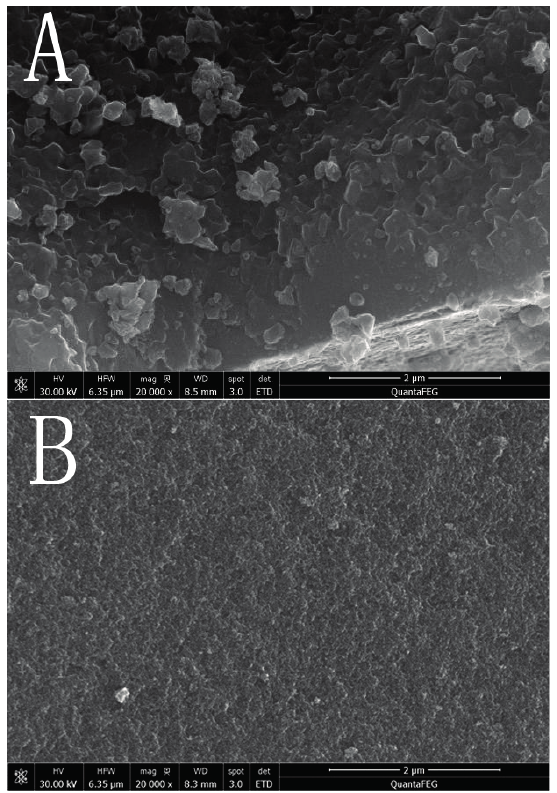
Figure 3. SEM images of TiO 2 ( A ) and La/Fe/TiO 2 ( B